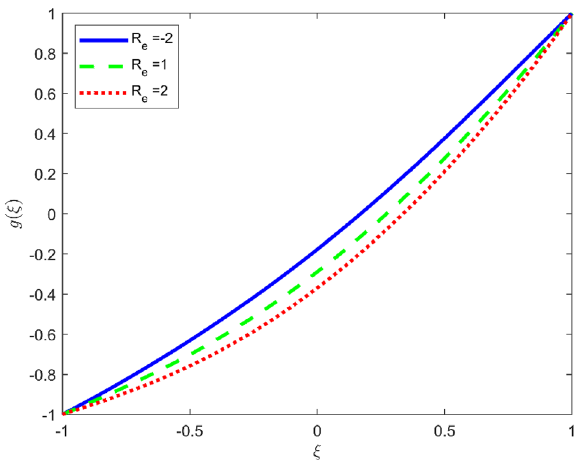
Figure 17. Effect of R e upon velocity profile g (ξ) , for selected values of β = 0.2, m = 1, Ha = 1, φ 1 = φ 2 =